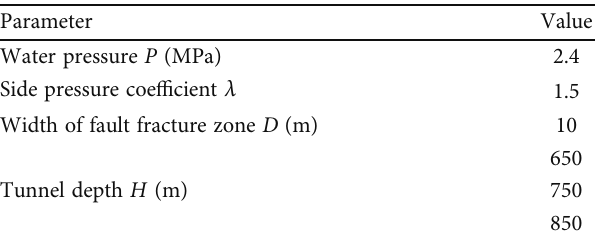
Figure 6: Changes in horizontal stress at the arch waist on the right side and vertical stress at the top of the vault under di ff erent widths of fault fracture Table 6: Calculation parameters for depth variation.